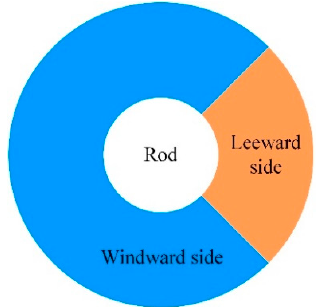
Figure 4. Schematic diagram of staining.